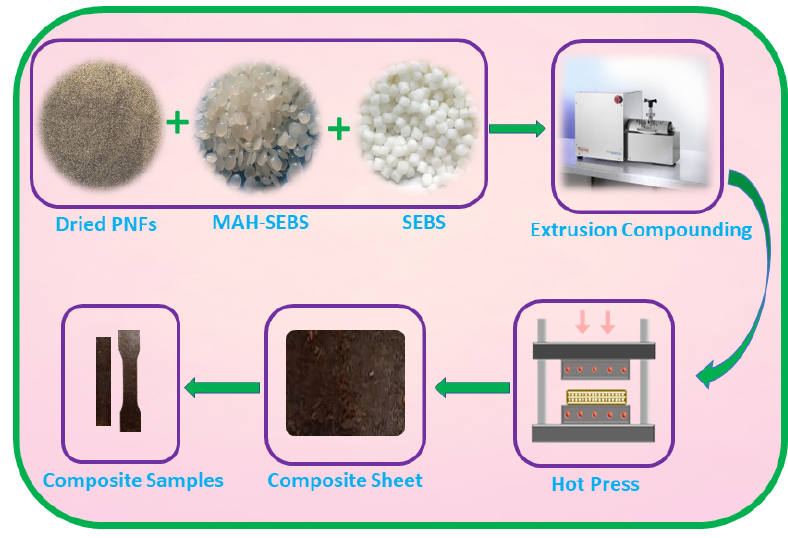
Figure 1. Composite preparation method.